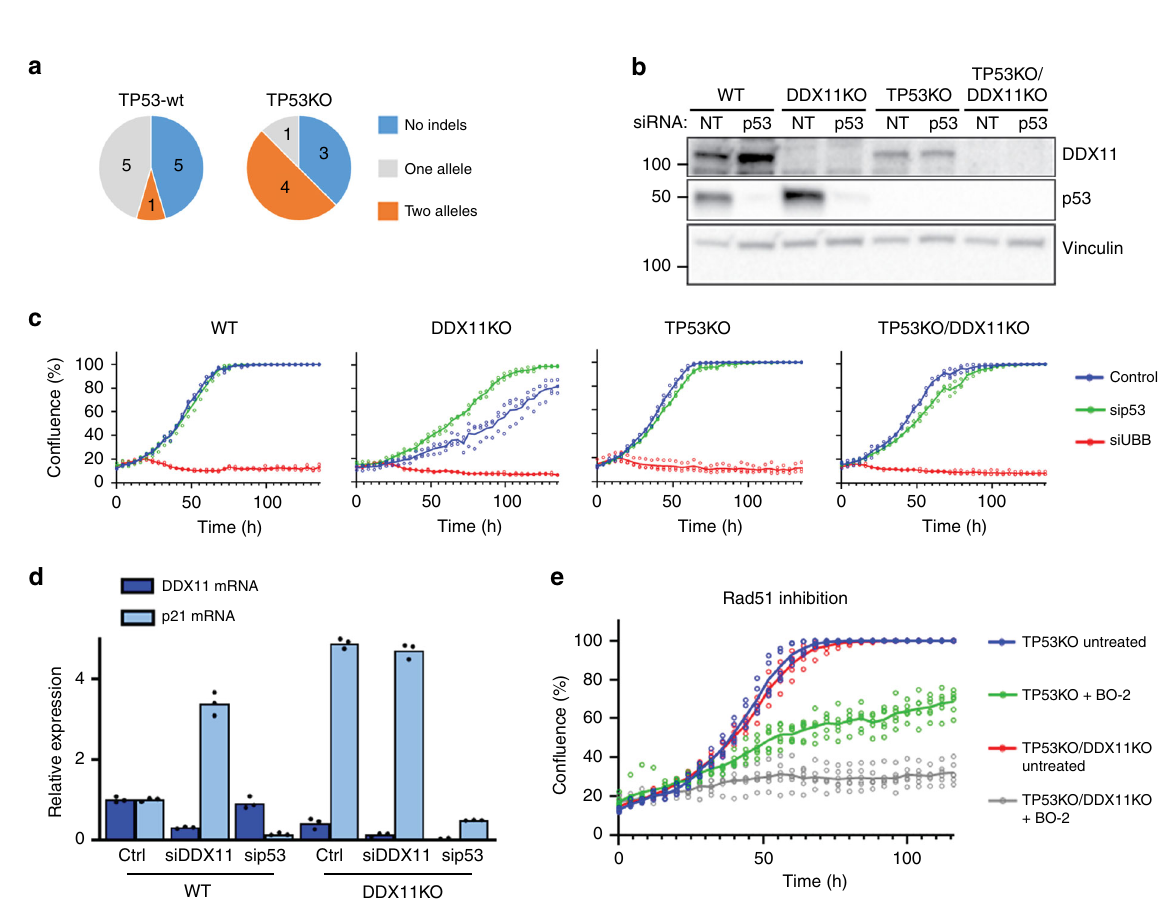
Fig. 4 DDX11 knockout causes TP53 activation and increased sensitivity to RAD51 inhibition. a RPE1-hTERT cells and RPE1-hTERT-TP53KO cells, both containing a doxycycline inducible Cas9 construct, were transfected with DDX11 guide RNA and indels were analyzed using Sanger sequencing.